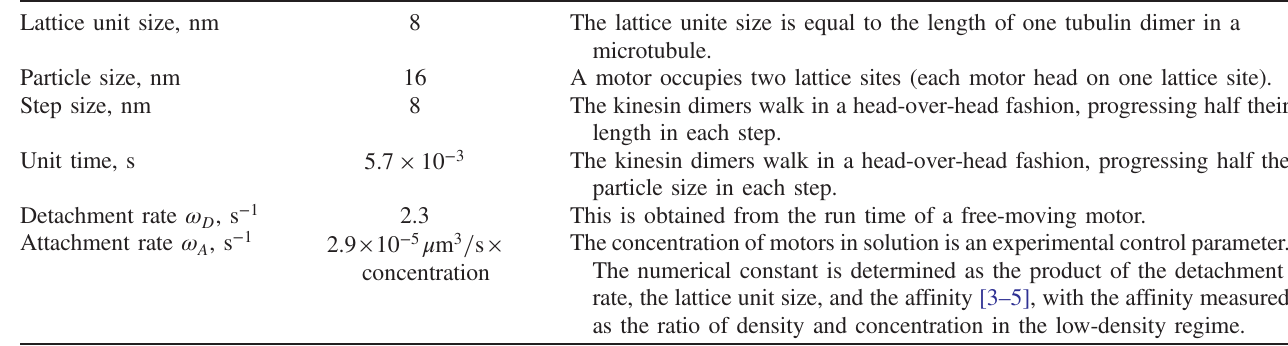
TABLE I. Connecting TASEP-LK units to physical units for OSM-3 motor proteins in buffer solutions PEM80 on microtubules. Lattice unit size,